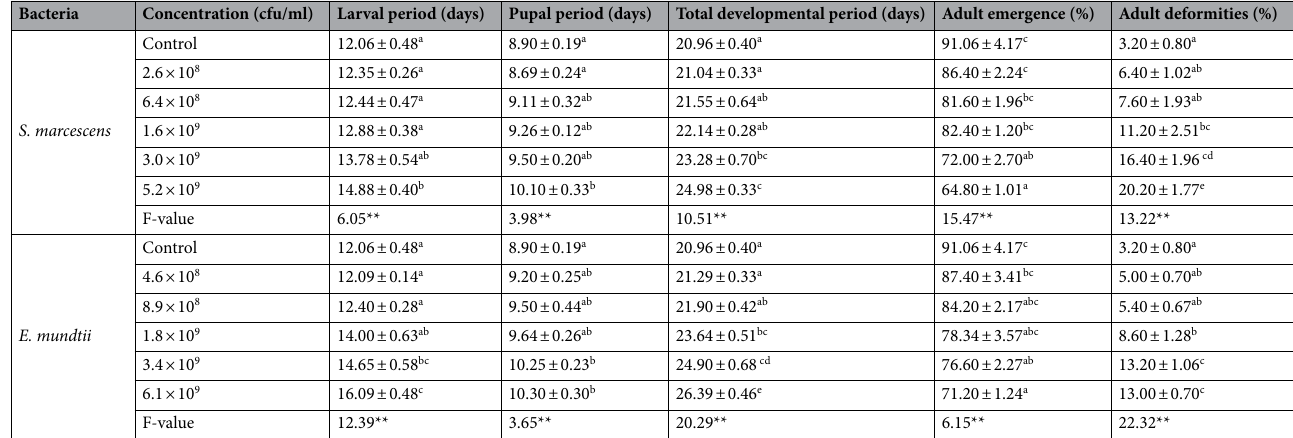
Table 1. Influence of different concentrations of S. marcescens and E. mundtii on development and adult emergence of S. litura . The values (Mean ± SE) followed by different letters (superscript) with in a column indicate significant differences at Tukey’s test p ≤ 0.05, **Significant at 1%